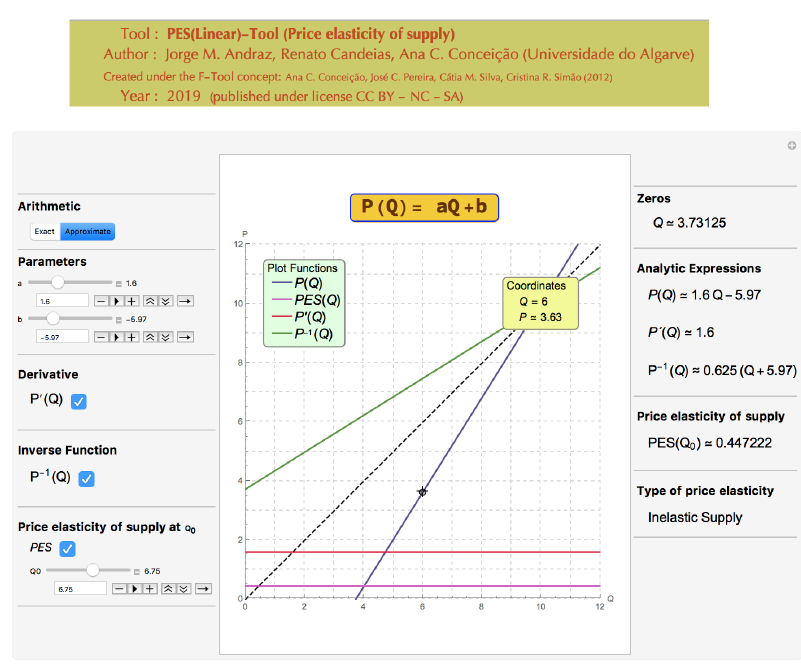
Figure 9. Example of an inelastic